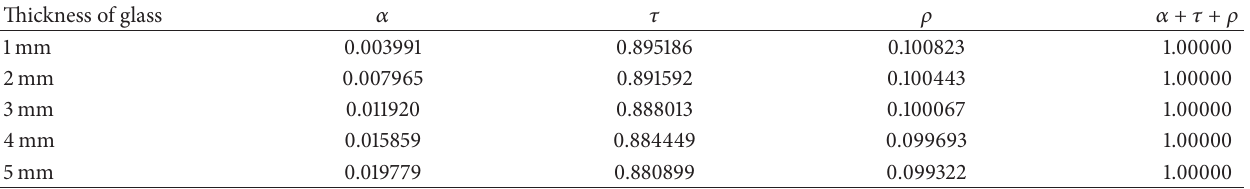
Table 1: The absorbance, reflectance, and transmittance of ultraclear glass at different thicknesses. Thickness of glass 𝛼 𝜏